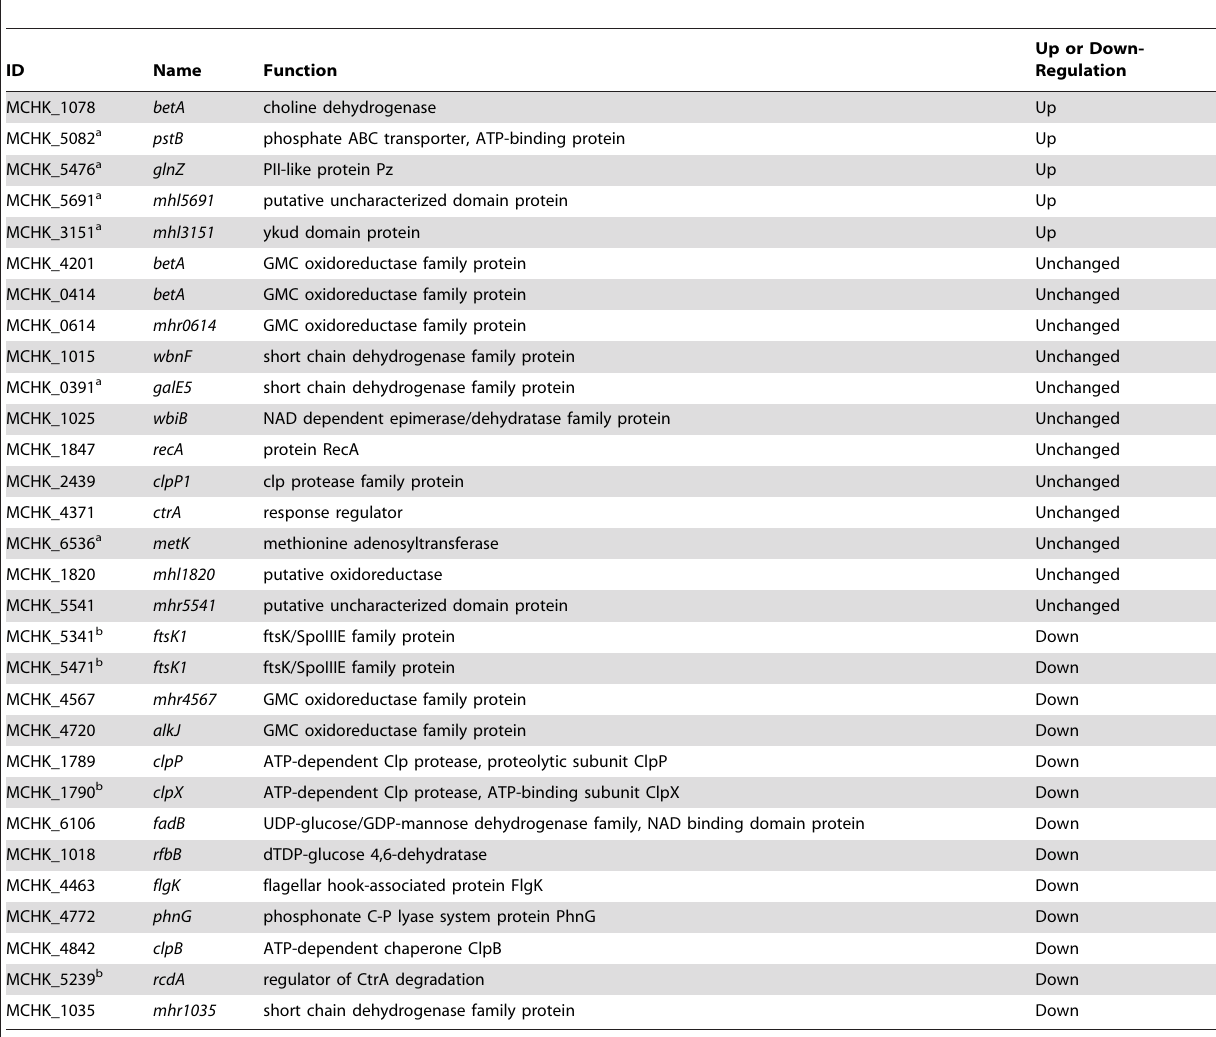
Table 4. The subnetwork of CtrA with interacting proteins in M. huakuii 7653R.